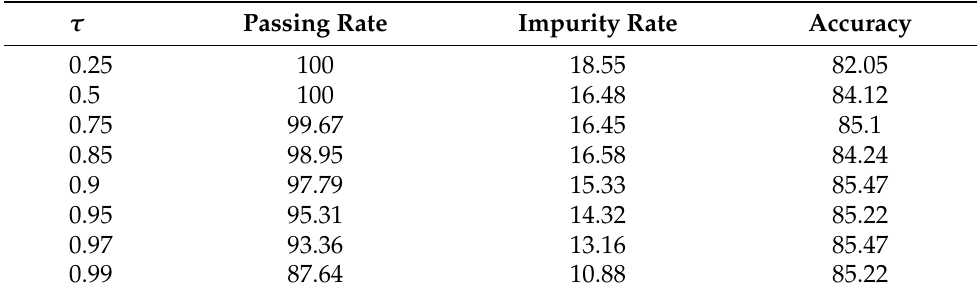
Table 3. Passing rate, impurity rate, and accuracy of test set for DSSL with different thresholds in the 60-label